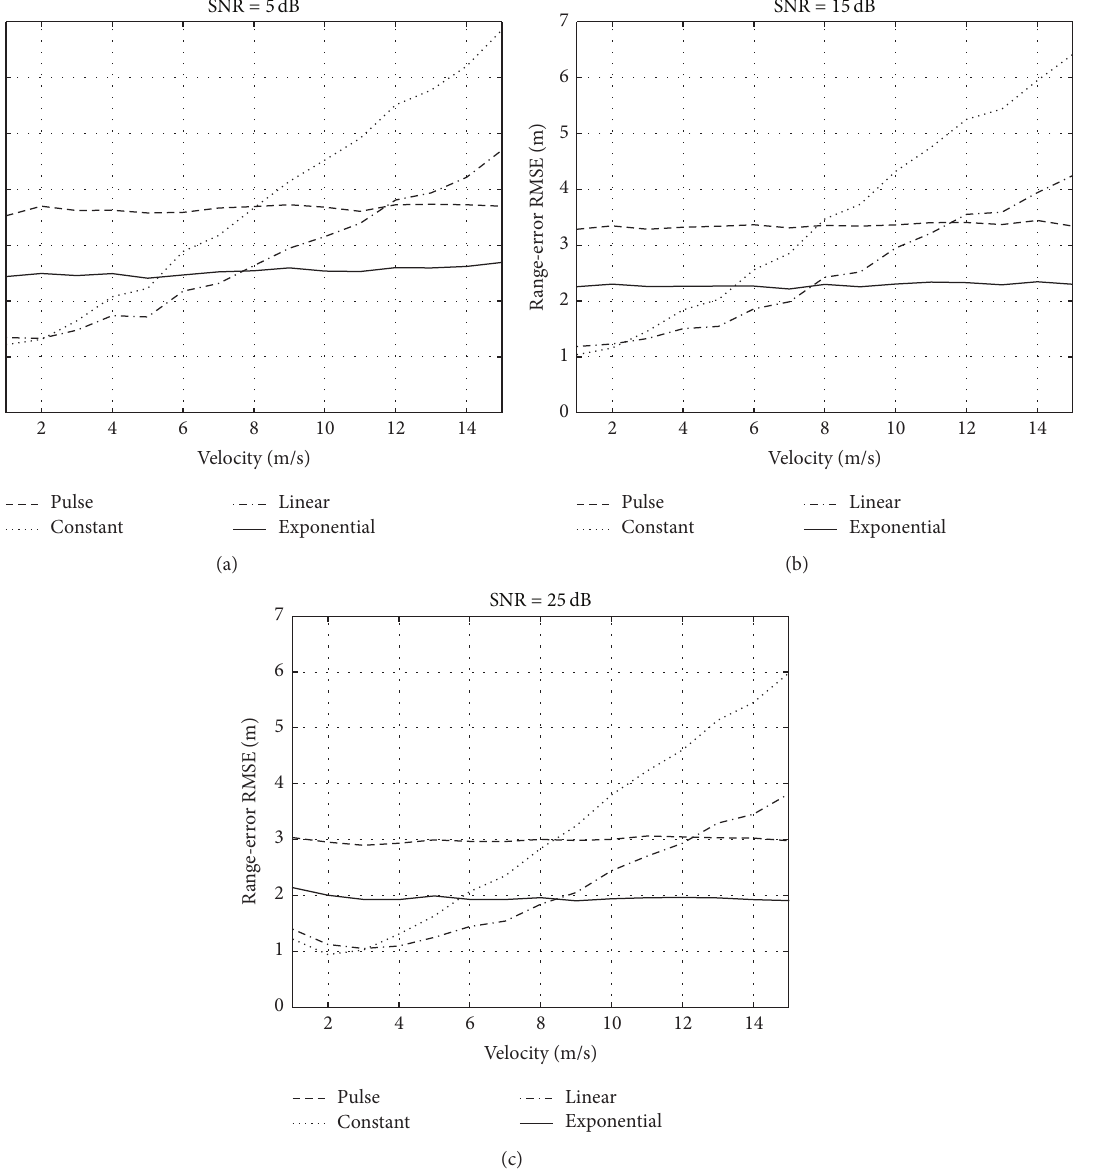
Figure 9: Range-error root-mean-square errors (RMSEs) of different forgotten factors versus velocity with 𝑎 = 0 m/s 2 . (a) SNR = 5 dB, (b) SNR = 15 dB, and (c) SNR = 25